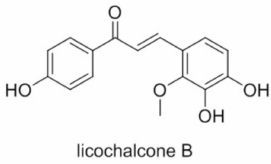
Figure 1. Chemical structure of